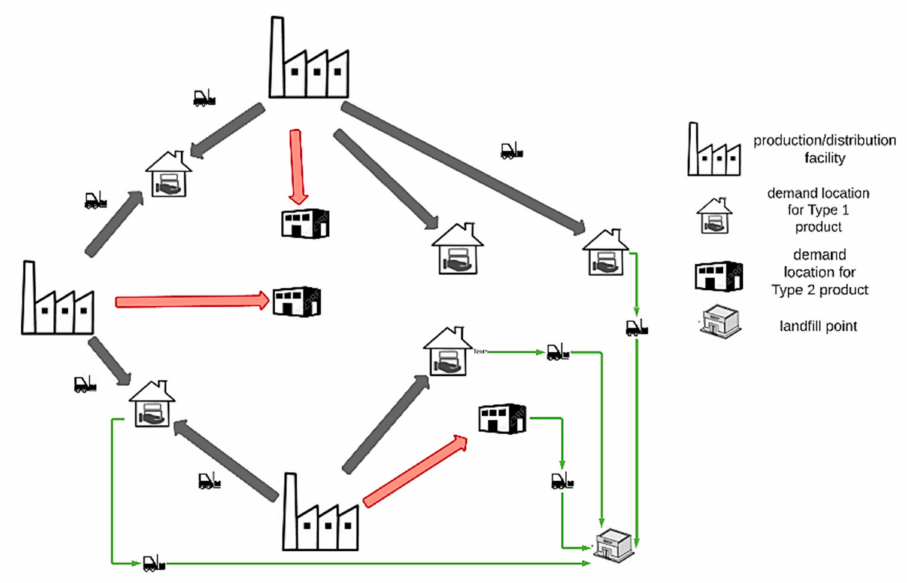
Figure 2. Design of distribution network for multi-quality products.